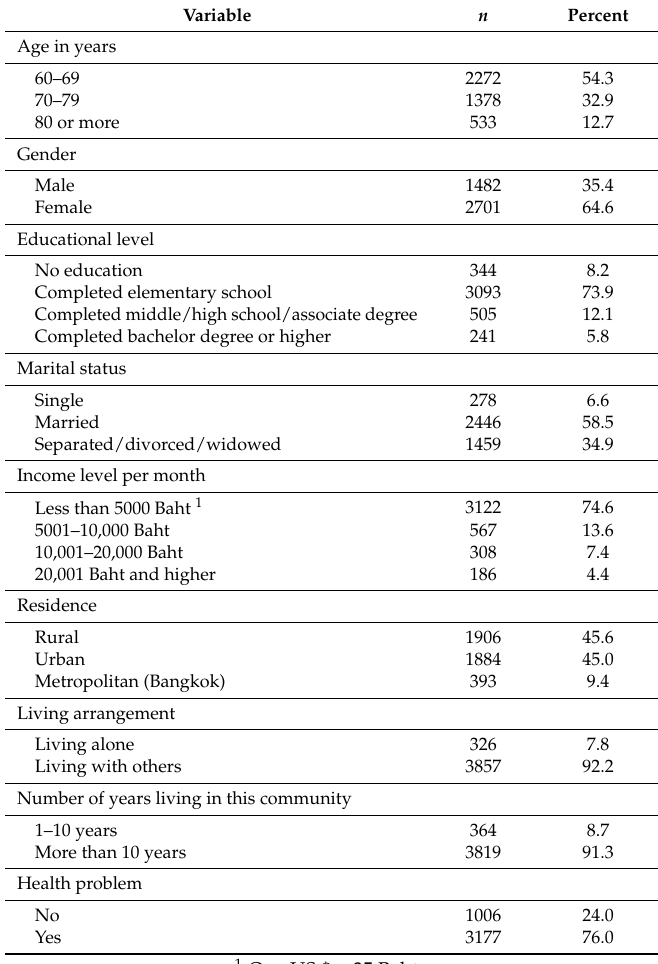
Table 1. Sample characteristics ( n =